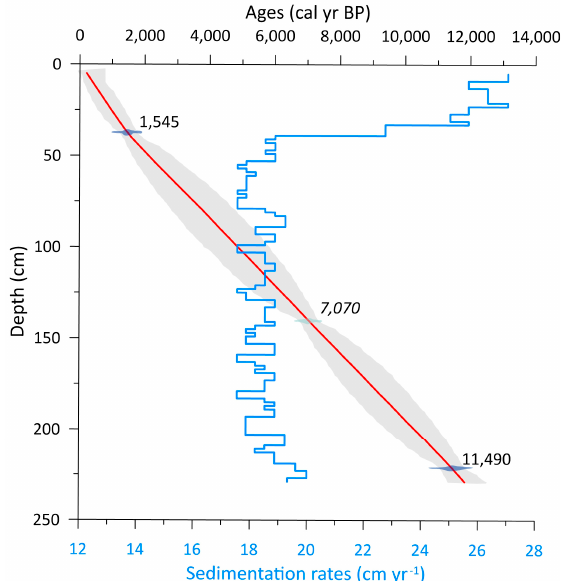
Figure 3. Age–depth model for core PS ‐ 6066 constrained from the Bacon software [55] to calibrated accelerator mass spectrometry 14 C dates from Table 1. Numbers are the calibrated ages (yr BP), and the one in italics is the added age from interpolation with PS ‐ 6050.